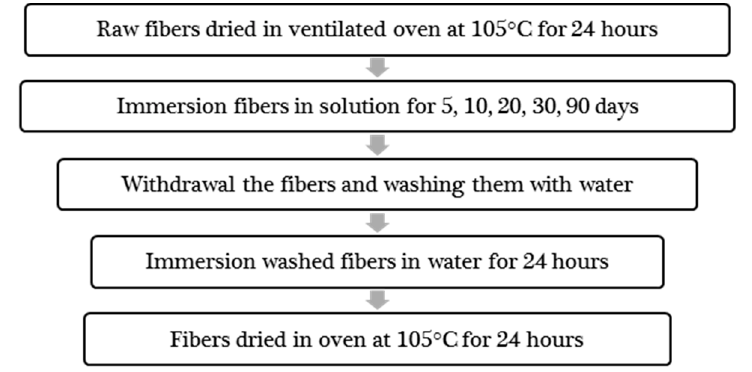
Figure 7. The exposure procedure.